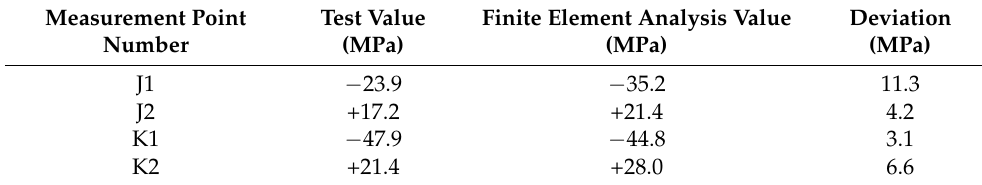
Table 4. Steady-state values of stress at maximum amplitude at each measurement point.